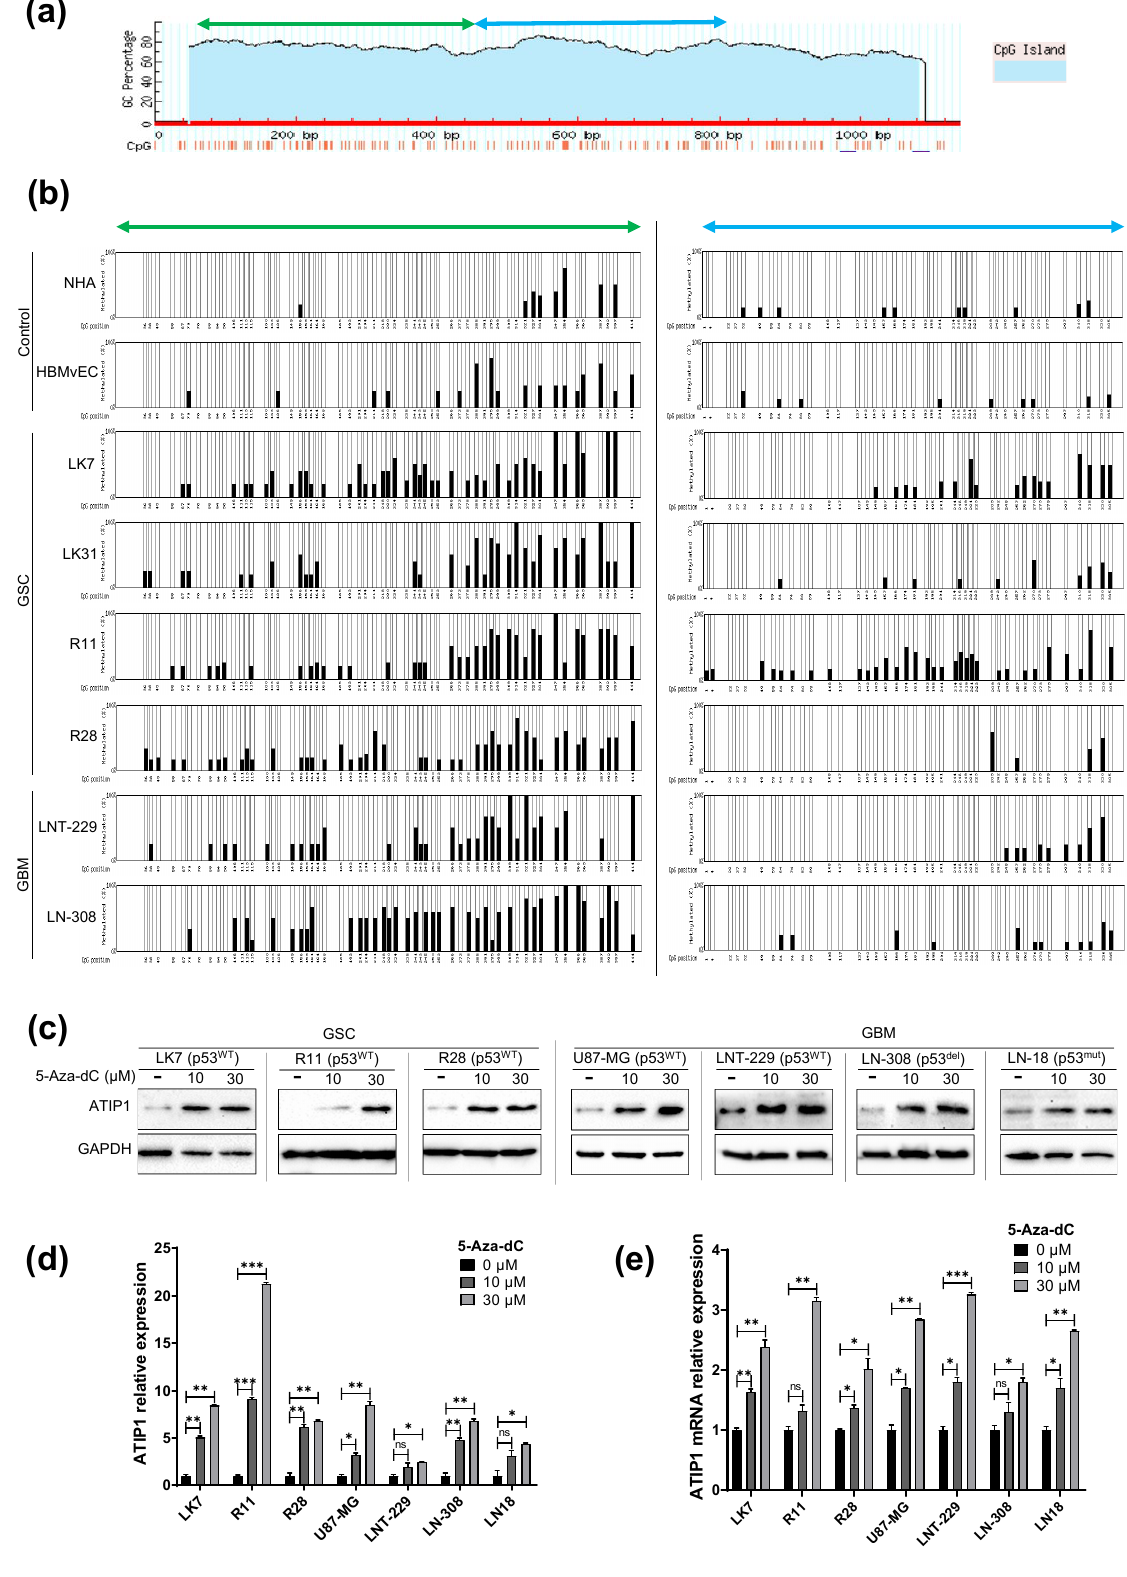
Figure 2. In glioma cells, the MTUS1 promoter region shows hypermethylation. ( a ) Localization of a predicted CpG island in the 5 (cid:48) upstream MTUS1 -TSS region (red). The green and blue labelled regions were analyzed for BSS and indicate the proximal (blue, 57 CpG) and distal (green, 41 CpG) part of the CpG island. ( b ) Percentage of methylation in